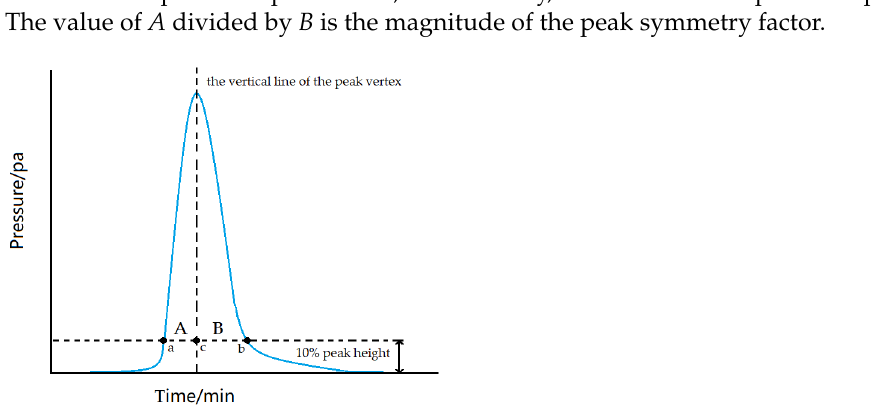
Figure 9. Schematic diagram of symmetry factor. The horizontal and vertical dashed lines are the 10% peak height line and the peak vertex vertical line respectively, intersecting at point c. The horizontal dotted line crosses the blue chromatogram at point a on the left and point b on the right. The distance from a to c is A, and similarly, the distance from c to b is B. The value of A divided by B is the magnitude of the peak symmetry factor.